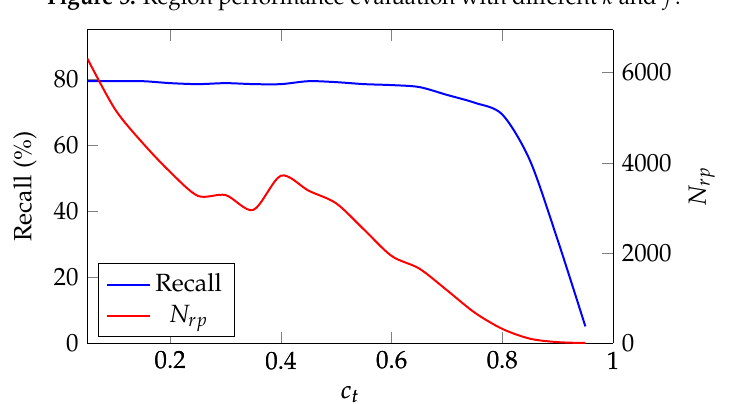
Figure 5. Region performance evaluation with different k and f .